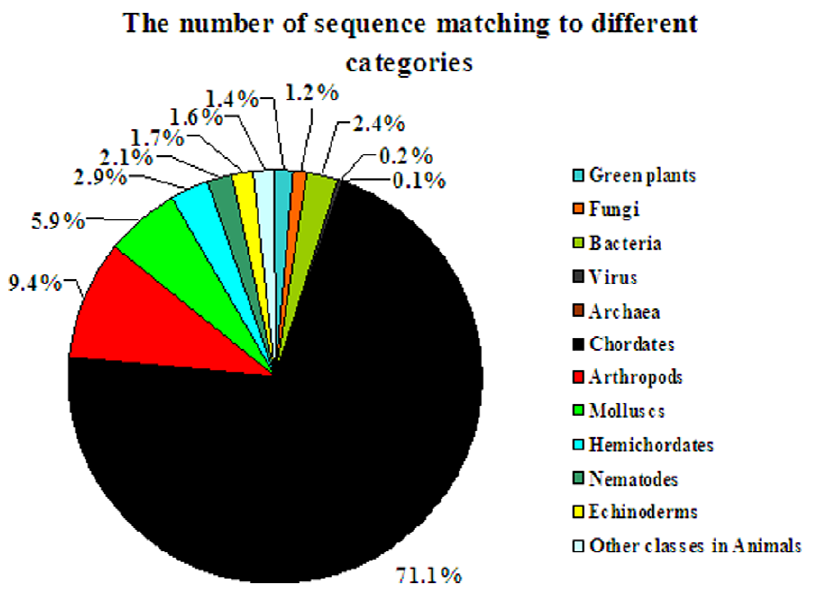
Figure 3. Taxonomic distribution of best match sequences with BLAST alignments to the H.diversicolor unigenes (E # 1e 2 5 ).